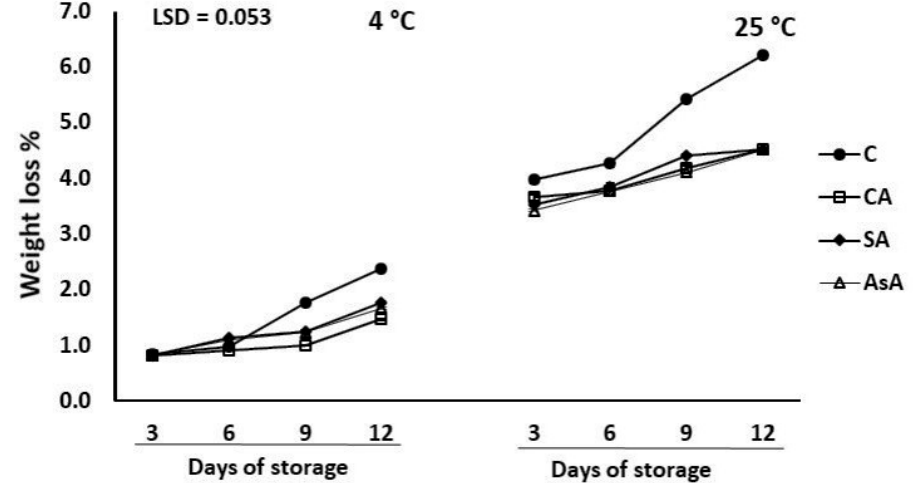
Figure 1. Effects of bio-stimulants B, control (C), citric acid (CA), salicylic acid (SA) and ascorbic acid (AsA), storage period SP (3, 6, 9 and 12 days) and storage temperature T (4 °C and 25 °C) on weight loss % of okra pods. Error bars are the ± SD of the means of three biological replicates for each temperature condition. LSD values ( p ≤ 0.05) for B = 0.02, SP = 0.02, T = 0.01, B × SP = 0.04, B × T = 0.03 and SP × T = 0.03. LSD for B × SP × T is presented on the figure.